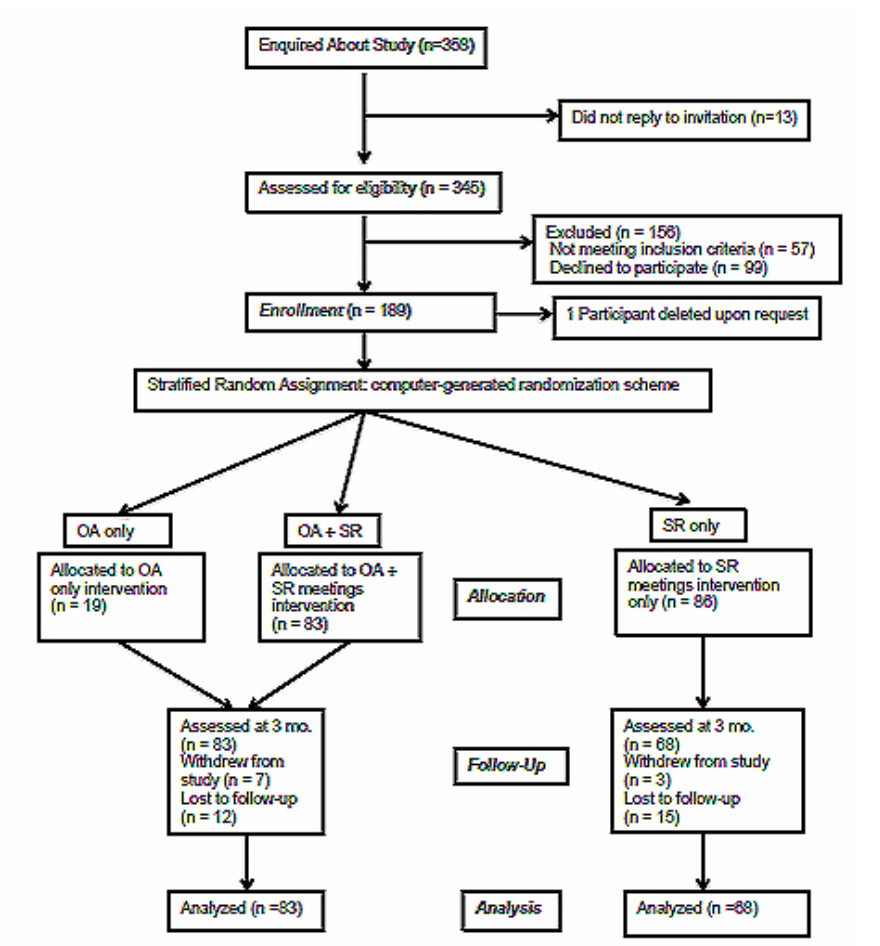
Figure 2. Flowchart of participant flow and follow-up.